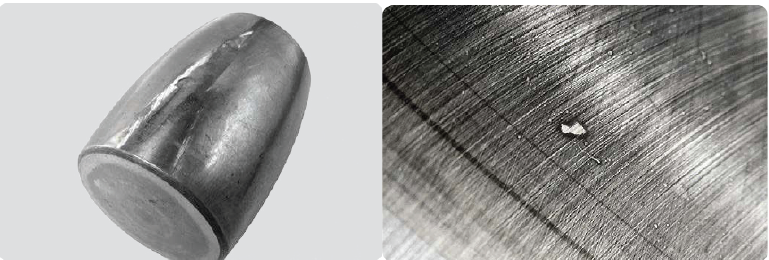
Figure 7. Plastic deformation failure. Overload ( left ) and indentation ( right ) [27]. Courtesy of SKF.